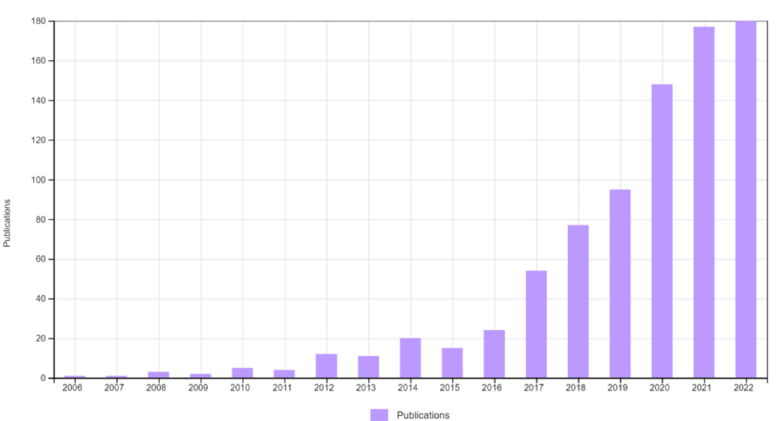
Figure 1. Graph depicting the number of publications on 2D MOFs over the years. Citation Report Graphic is derived from Clarivate Web of Science , Copyright Clarivate 2022. All rights reserved. (Keywords: 2D two-dimensional metal-organic frameworks MOF). Table 2. Comparison of the nonenzymatic glucose sensing properties of 2D MOFs with other mate ‐ rials.